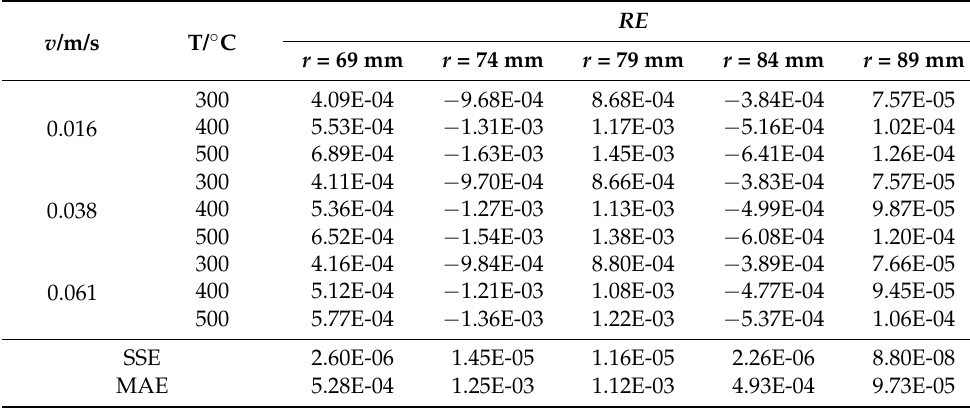
Table 4. The prediction model accuracy of sectional radial